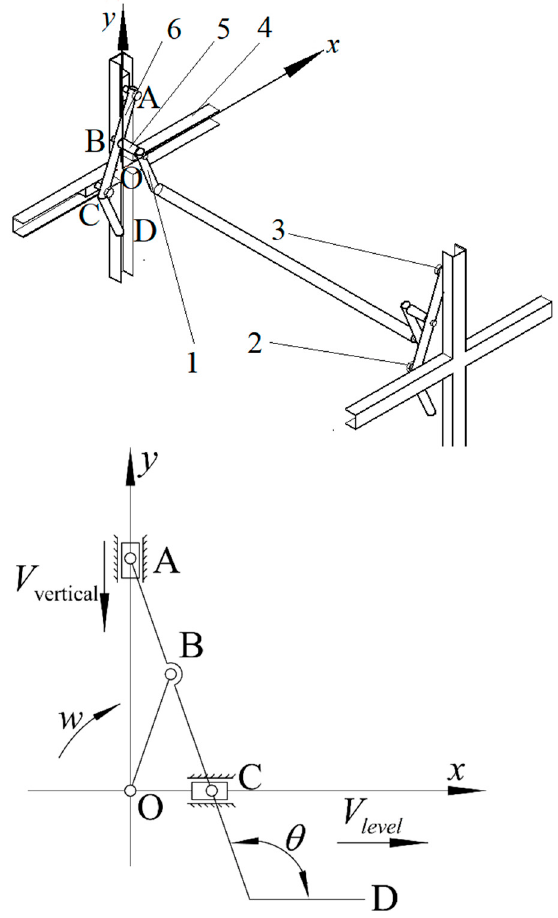
Figure 3. Schematic diagram of the movement analysis of the film picking mechanism. 1. Upper rocker; 2. Down rocker; 3. Support bolt; 4. Horizontal guide rail; 5. Connecting rod; 6. Longitudinal guide rail.